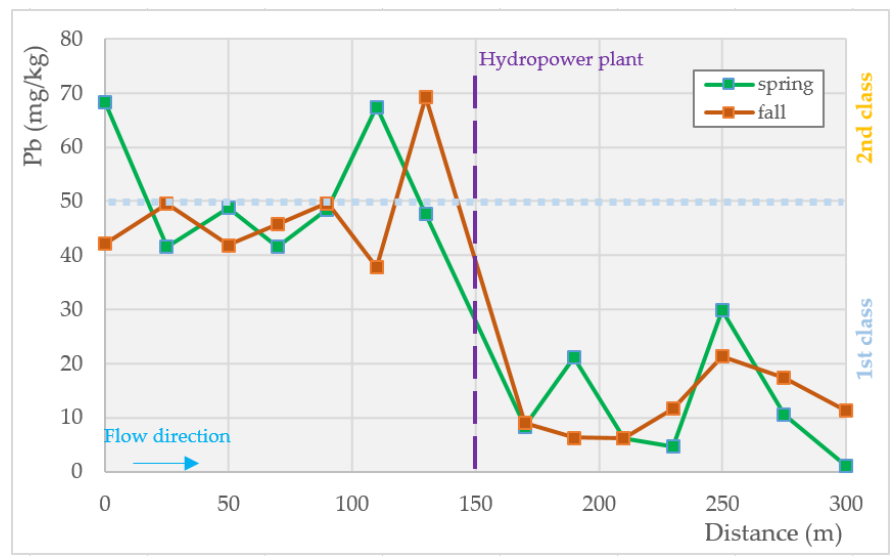
Figure 9. Changes in lead concentrations in sediments in spring and fall near the hydropower plant on the Ślęza River, along with the geochemical classification.